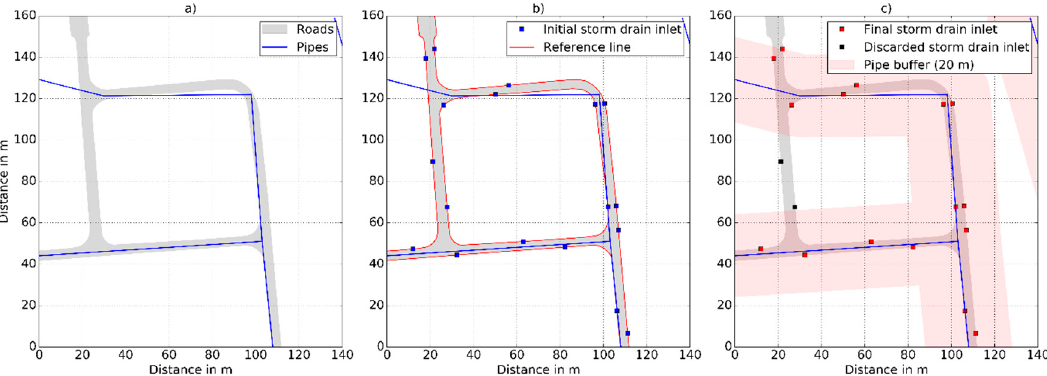
Figure 2. Generation of a synthetic storm drain inlet network: ( a ) Input data consisting of dissolved road polygon shapefile and pipe network polyline shapefile. ( b ) Creating reference line (0.25 m inside of road polygon shapefile) and placing points on reference line at an equidistant space of 50 m. ( c ) Storm drain inlets at a distance >20 m to nearest pipe segment are discarded.